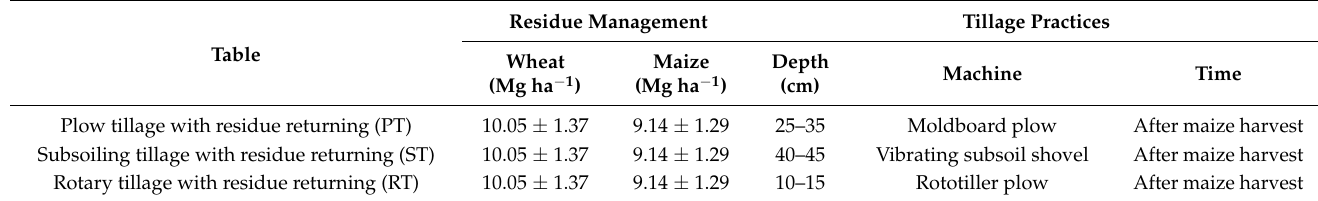
Table 1. The detailed operation of three tillage management methods. Residue Management Tillage Table